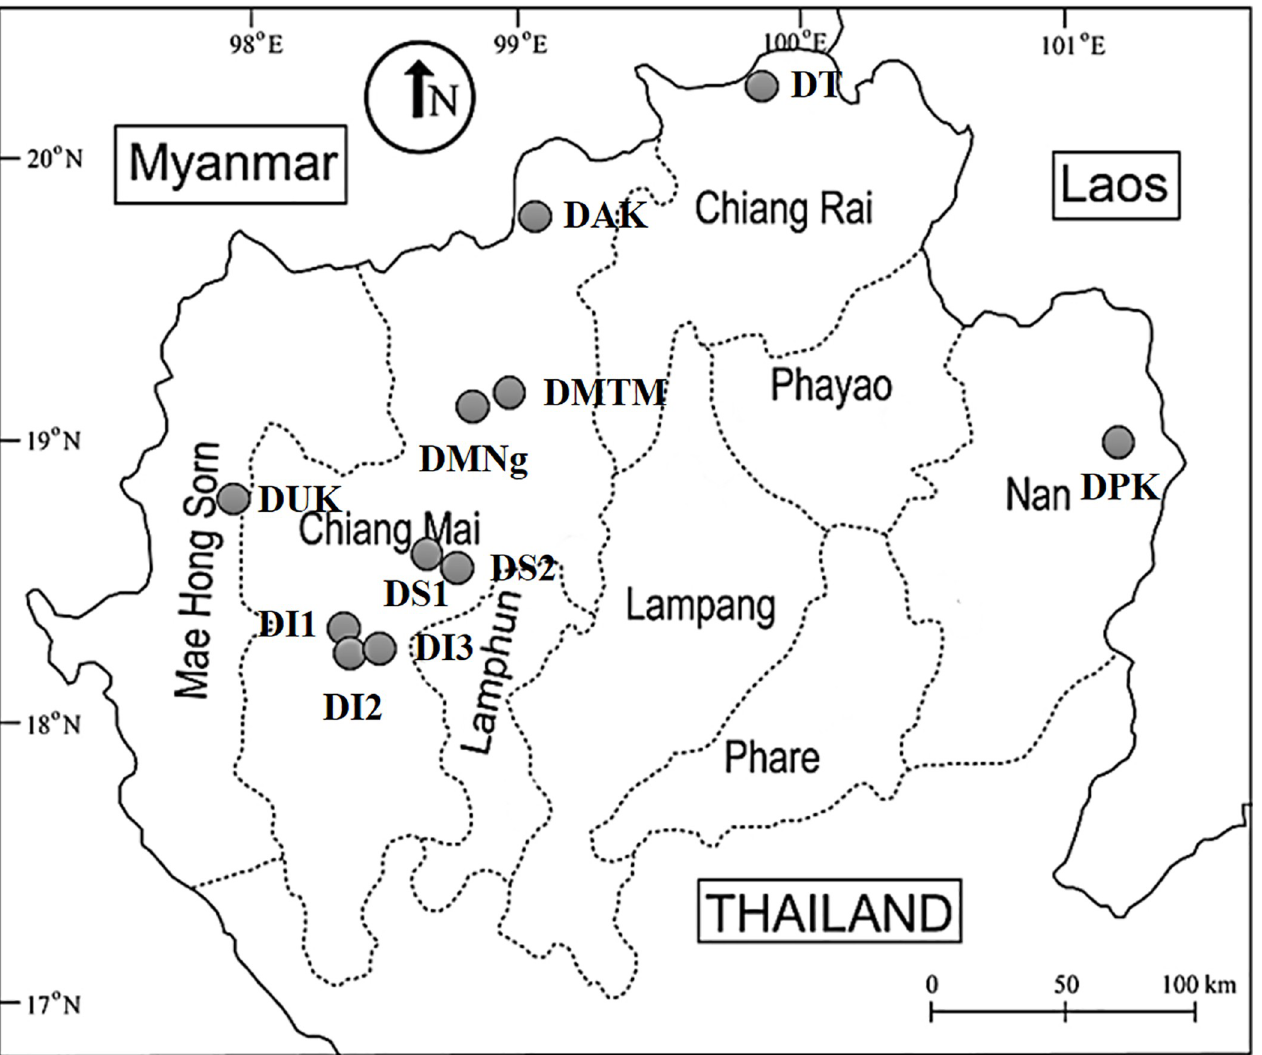
Fig 1. Map of the collection sites (grey dots) of native bumblebees in northern Thailand. Code name are abbreviated as following: DS = Doi Suthep, DI = Doi Inthanon, DMTM = Doi Mae Thaman, DAK = Doi Ang Khang, DMNg = Doi Mon Ngao, DUK = Doi Mae U Kho, DT = Doi Thong, DPK = Doi Phu